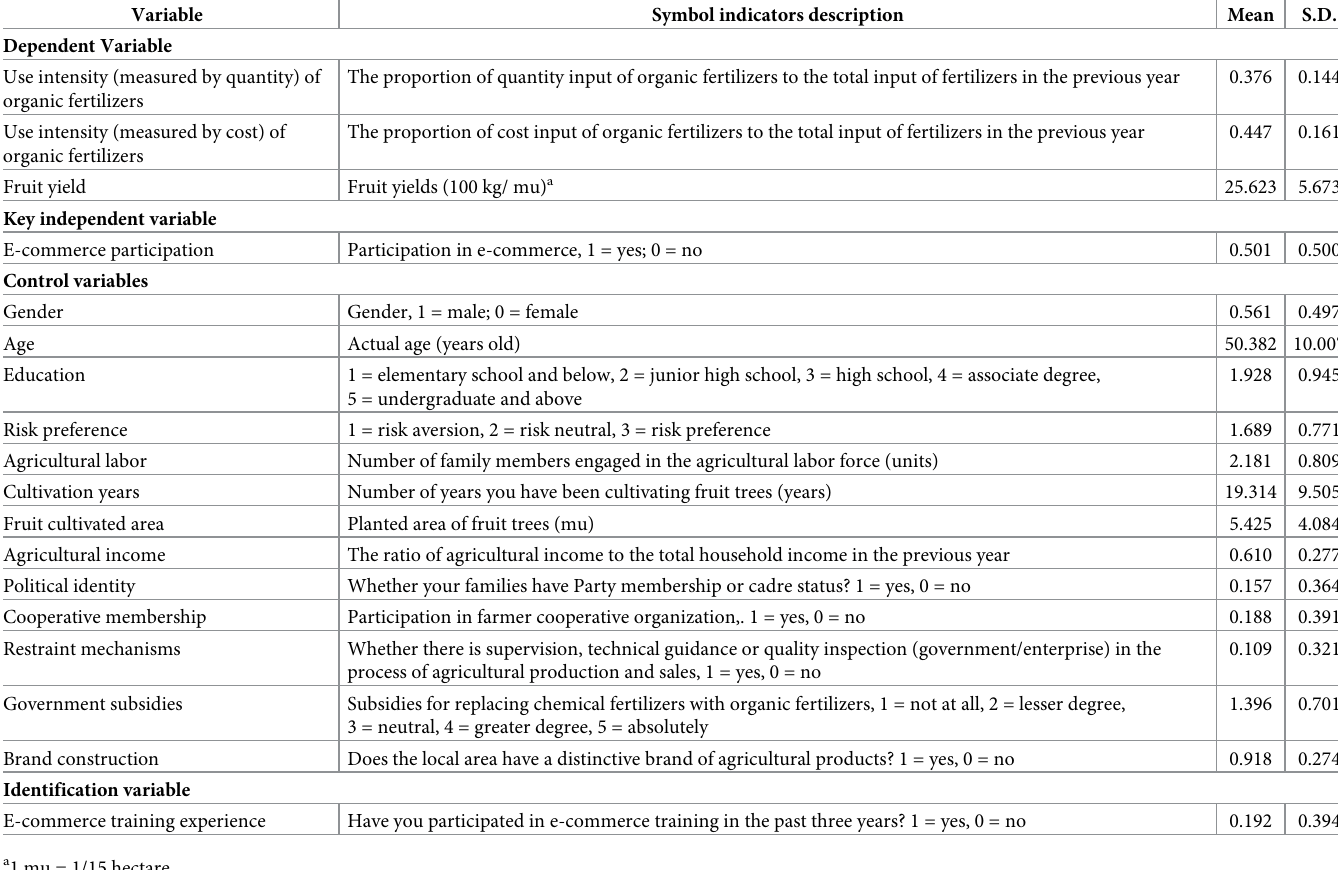
Table 1. Definition and descriptive